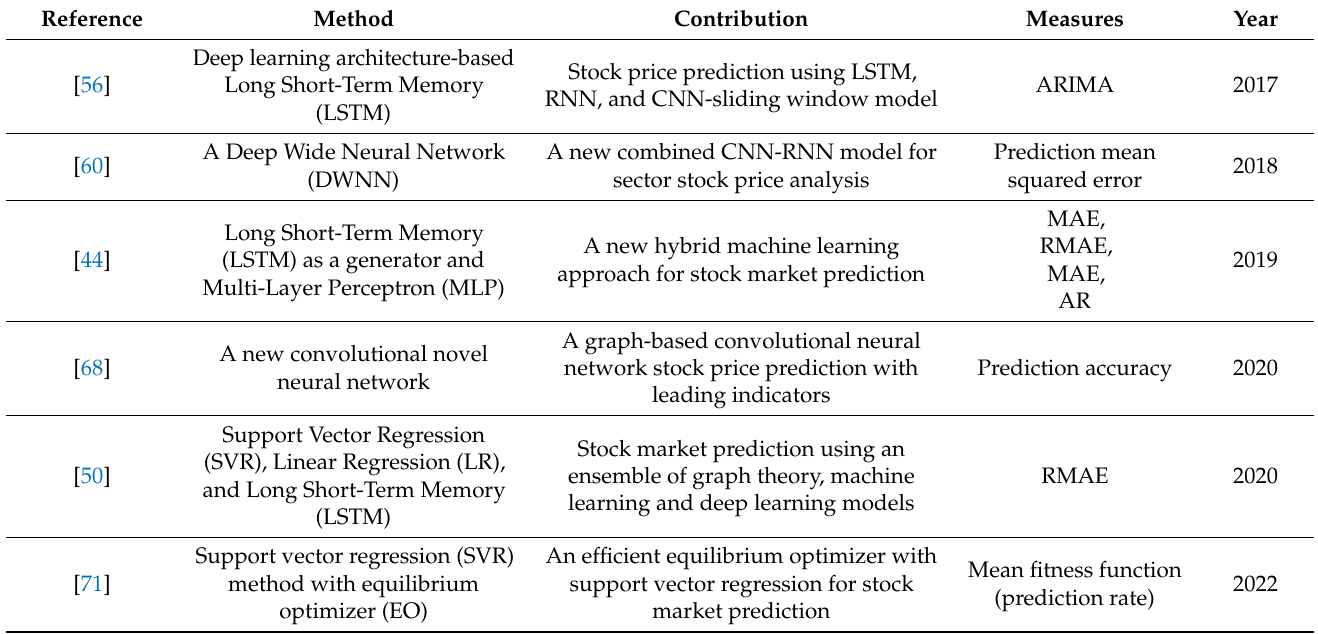
Table 1. An overview of the most related